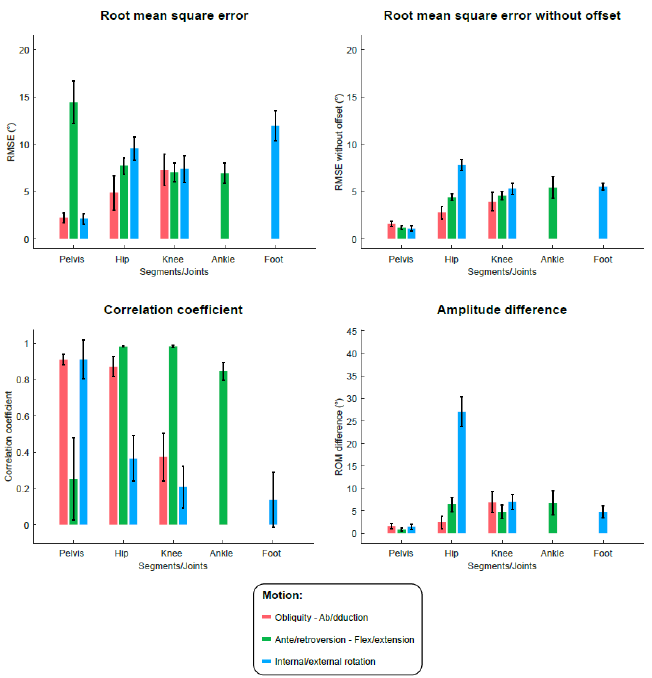
Figure 6. Metrics (root mean square error (RMSE), RMSE centered at the mean, correlation coefficient and difference in range of motion (ROM)) of validity evaluation of the method applied to the IMU data against the optoelectronic reference. Histograms represent the mean values (and interval confidence bars) for all participants, for each joint/segment and each plane.